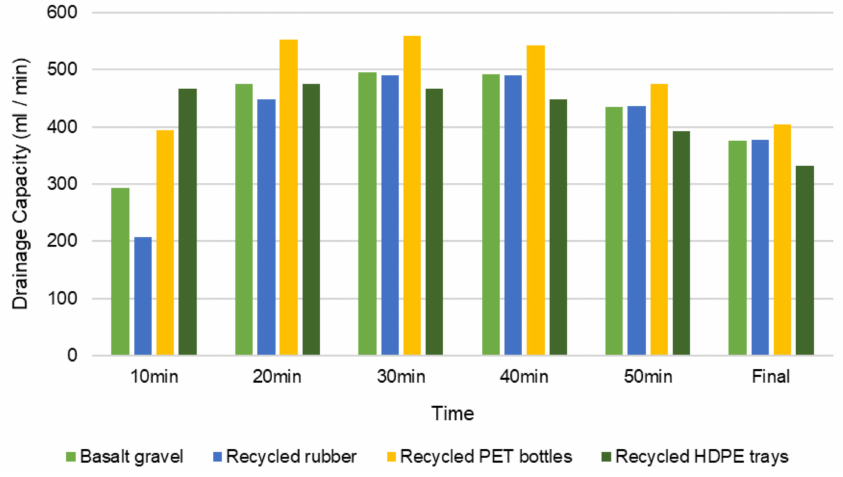
Figure 9. Average behavior of drained water (mL / min) for intense rain conditions between post-drought and stable